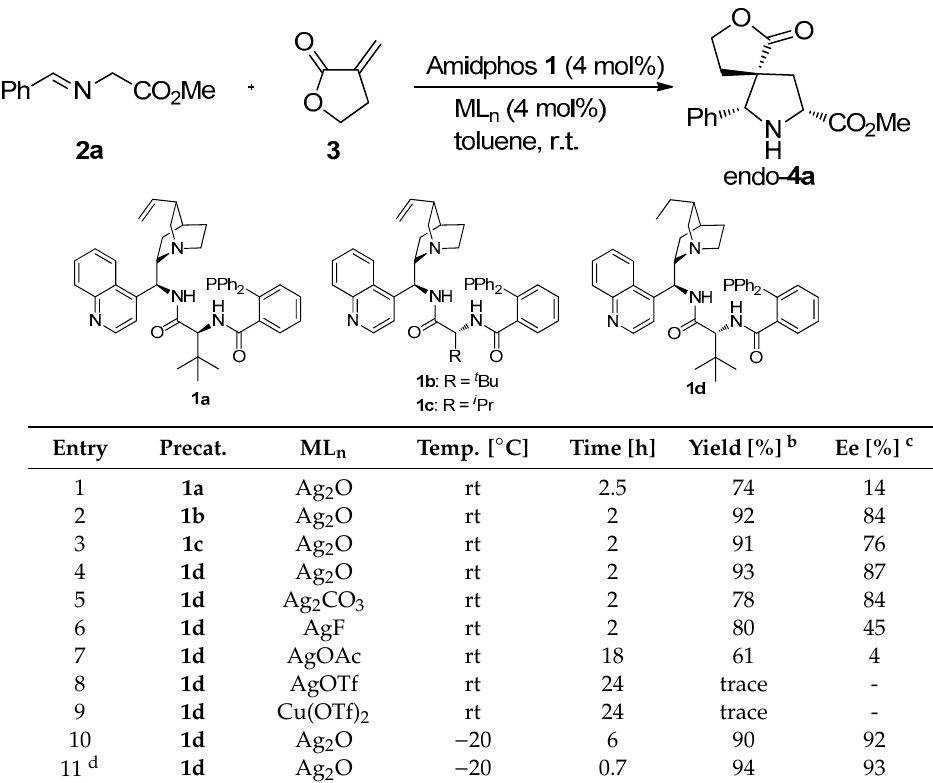
Table 1. Optimization of the reaction conditions between α -imino ester 2a and α -methylene- γ - butyrolactone 3 a .